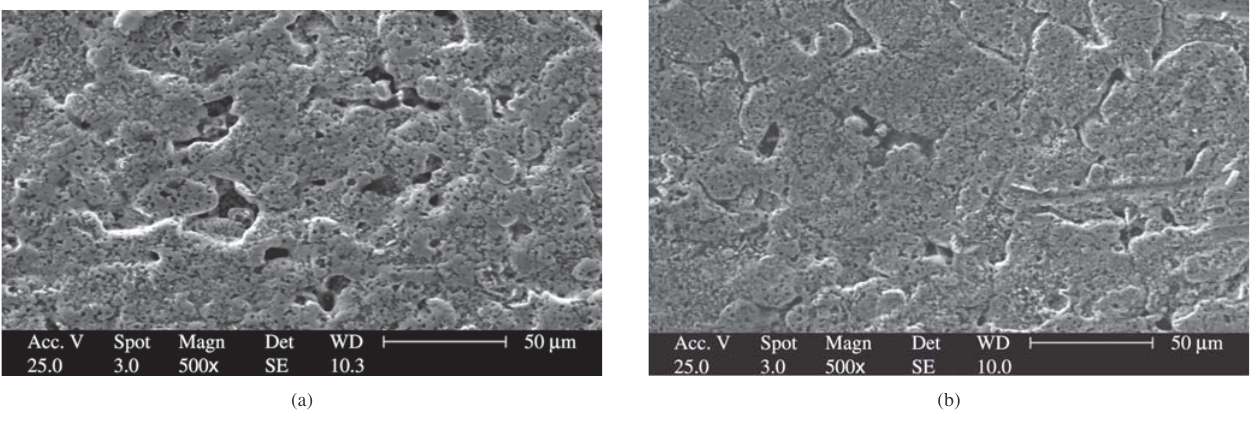
Figure 4. Scanning electron micrographs of potentiostatically aged electrodes: a) 2; b)